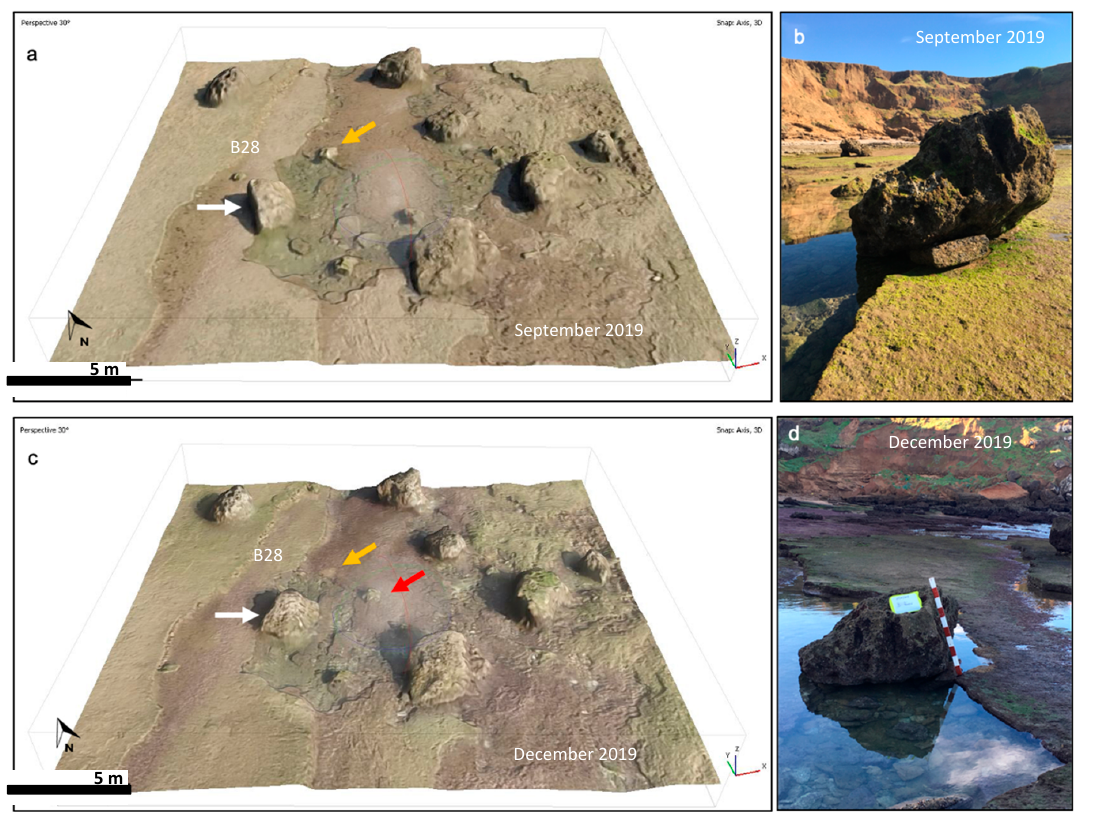
Figure 12. ( a ) Initial position of boulder B28 (white arrow); orange arrow shows the position of a small clast near B28; ( b ) photo of B28 in September 2019; ( c ) displacement of B28 (white arrow), initial position of small clast (orange arrow) and its new position (red arrow); ( d ) photo of B28 in December 2019, with bar scale.